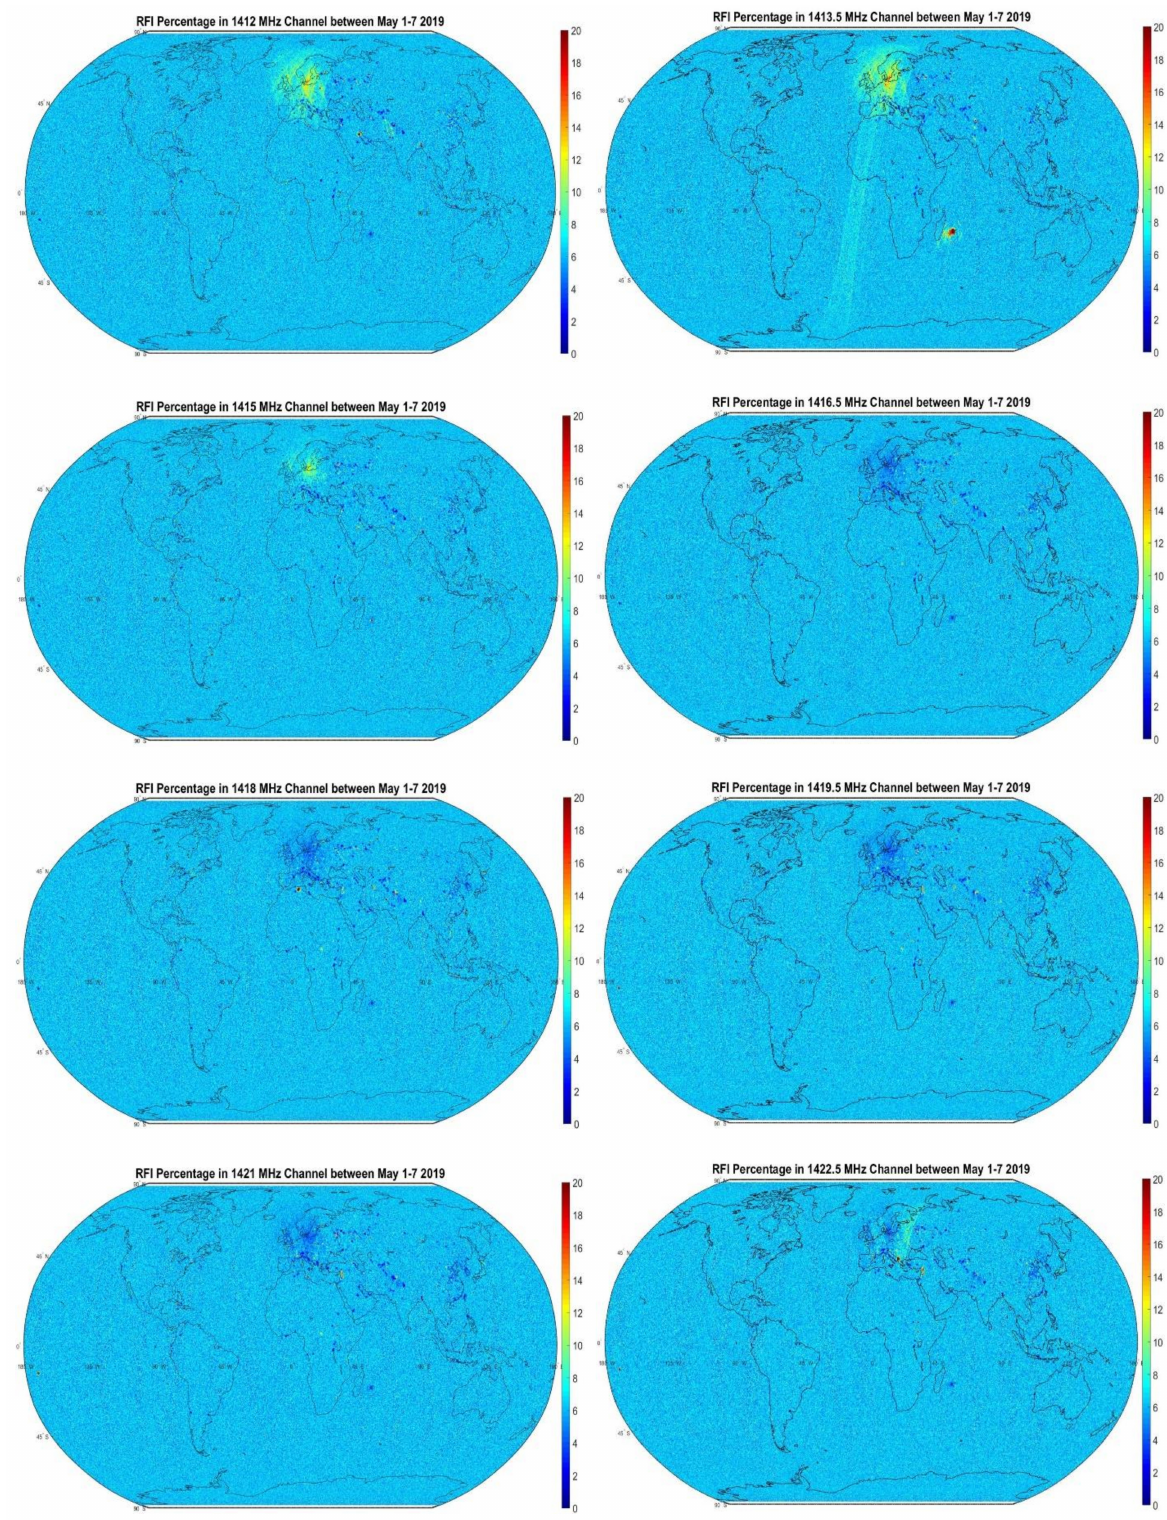
Figure 7. RFI percentage in 8 SMAP sub-band channels from 1412 to 1422.5 MHz between 1 and 7 May 2019 on 0.25 ◦ × 0.25 ◦ gridded maps. The background non-zero RFI percentage is due to false alarms in RFI detection. Note the significant RFI presence over Europe at 1412, 1413.5, and 1415 MHz, over Reunion Island at 1413.5 MHz, and over Eastern Europe and the Middle East at 1422.5